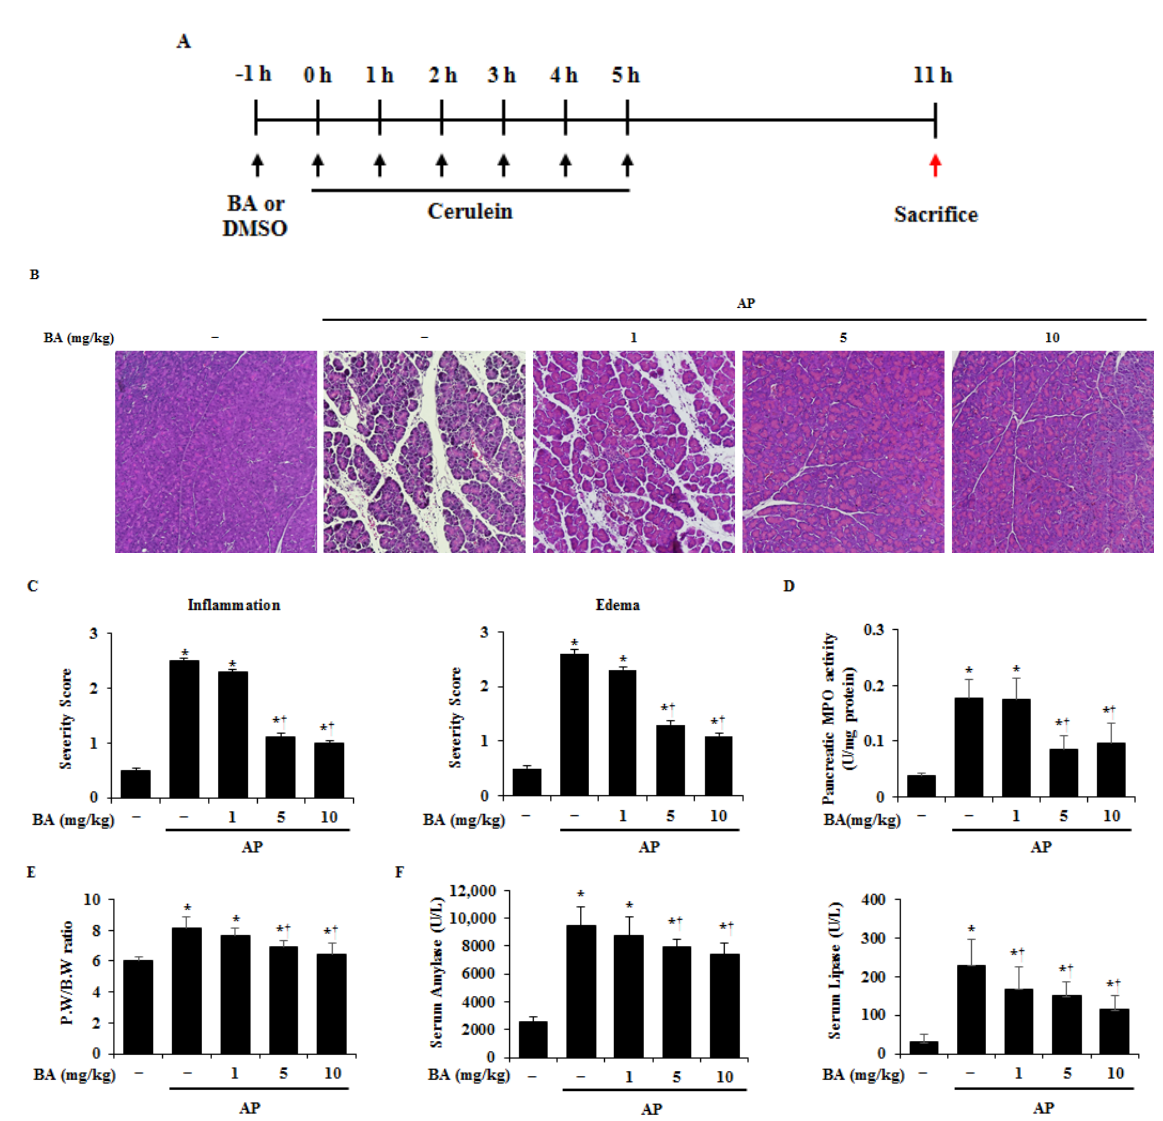
Figure 1. Effect of betulinic acid (BA) on pancreatic damage in cerulein-induced acute pancreatitis (AP). ( A ) Mice were pretreated with BA (1, 5, or 10 mg/kg) or dimethyl sulfoxide (DMSO) for 1 h, then cerulein (50 µg/kg) was intraperitoneally injected into the mice every hour for 6 h. The mice were then sacrificed at the end of 6 h, that is, after the last cerulein injection. ( B ) Representative hematoxylin and eosin (H&E)-stained pancreas section (200× magnification). ( C ) Histological sections of the pancreas were scored from 0 (normal) to 3 (severe) for inflammation and edema. ( D ) Pancreatic myeloperoxidase (MPO) activity. ( E ) Pancreas weight/body weight (PW/BW) ratio. (F) Serum levels of amylase and lipase. Data have been represented as mean ± SEM for six mice in each group. Results are representative of three experiments. * p < 0.05 vs. DMSO treatment alone. † p < 0.05 vs. cerulein treatment alone.